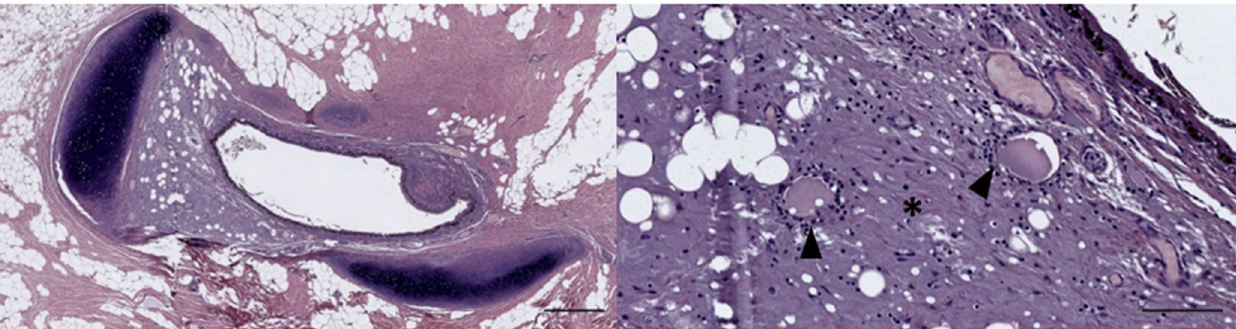
Figure 14. A histological image (HE staining) of a transverse section through the external ear canal of a harbour porpoise, about 4 cm beneath the skin (UT1718_L1402). Note the perivascular presence (cuffing) of lymphocytic cells and the presence of macrophages (arrows); oedema (asterisk) with protein leakage associated with an inflammatory process, with splitting of collagen fibres. Scale bar left = 500 µm, right = 100 µm.